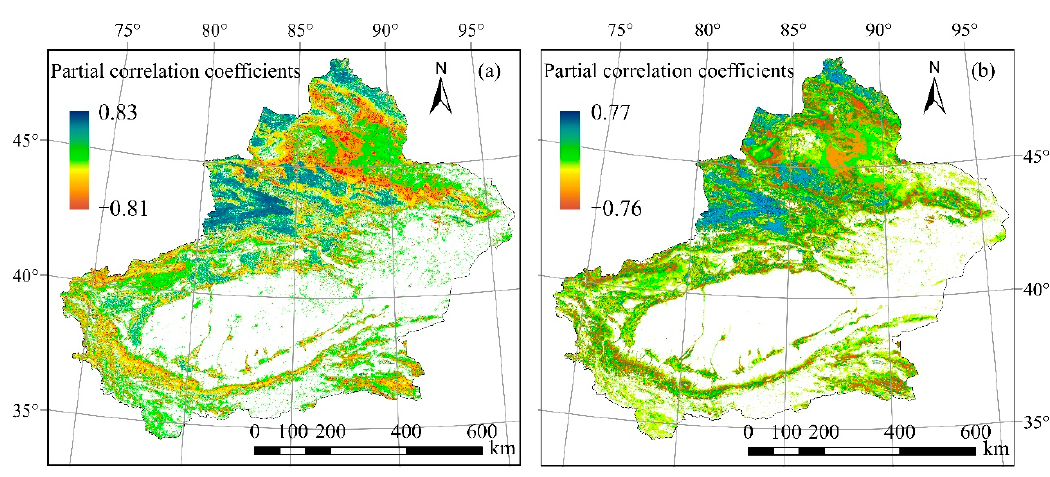
Figure 8. The partial correlation coe ffi cient of vegetation NDVI (normalized di ff erence vegetation index) with T max ( a ) and T min ( b ) in the arid and semiarid